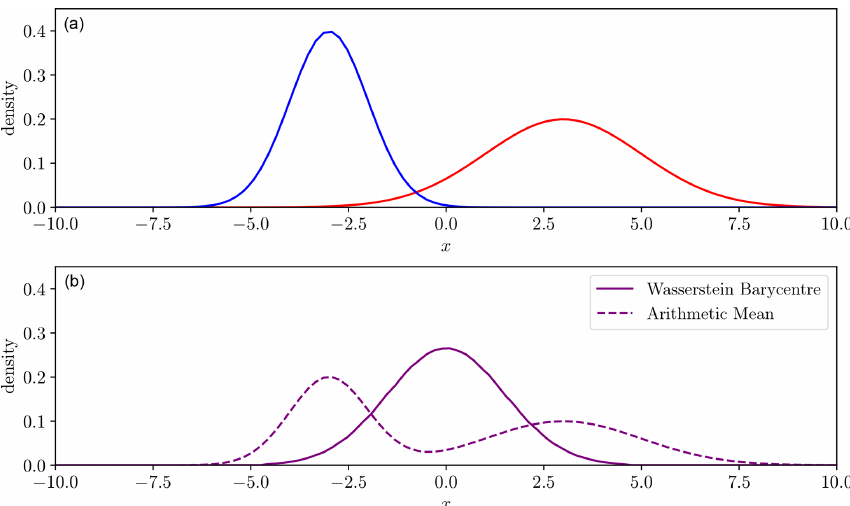
Figure 6. Two Gaussian density functions (blue, red, a ) with one spatial/temporal dimension x . The Wasserstein barycentre of these densities (solid purple, b ) and the mean (dashed purple, b